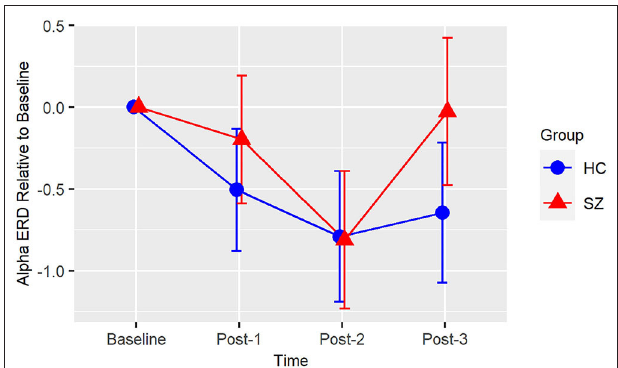
FIGURE 3 | Alpha ERD. Graph showing change in alpha ERD for post-VHFS assessment blocks relative to baseline. Alpha ERD showed a trend toward overall enhancement post-VHFS relative to baseline; specifically, this enhancement reached statistical significance for Post-2 but not Post-1 or Post-3 across healthy control participants (shown in blue) and schizophrenia patients (shown in red). Groups did not differ in alpha ERD potentiation post-VHFS. Error bars denote standard errors within